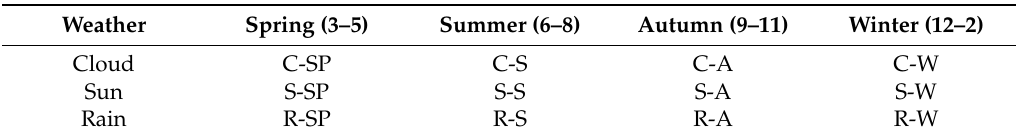
Table 3. The 12 typical types of